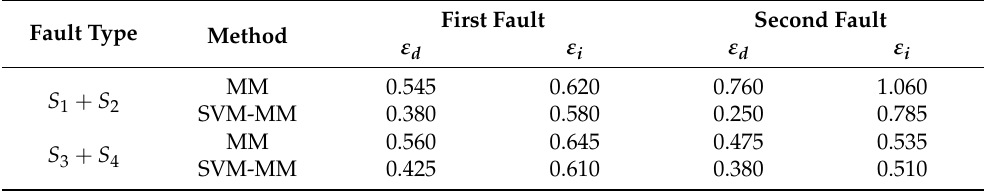
Table 4. Multiple-Fault Diagnosis Performance